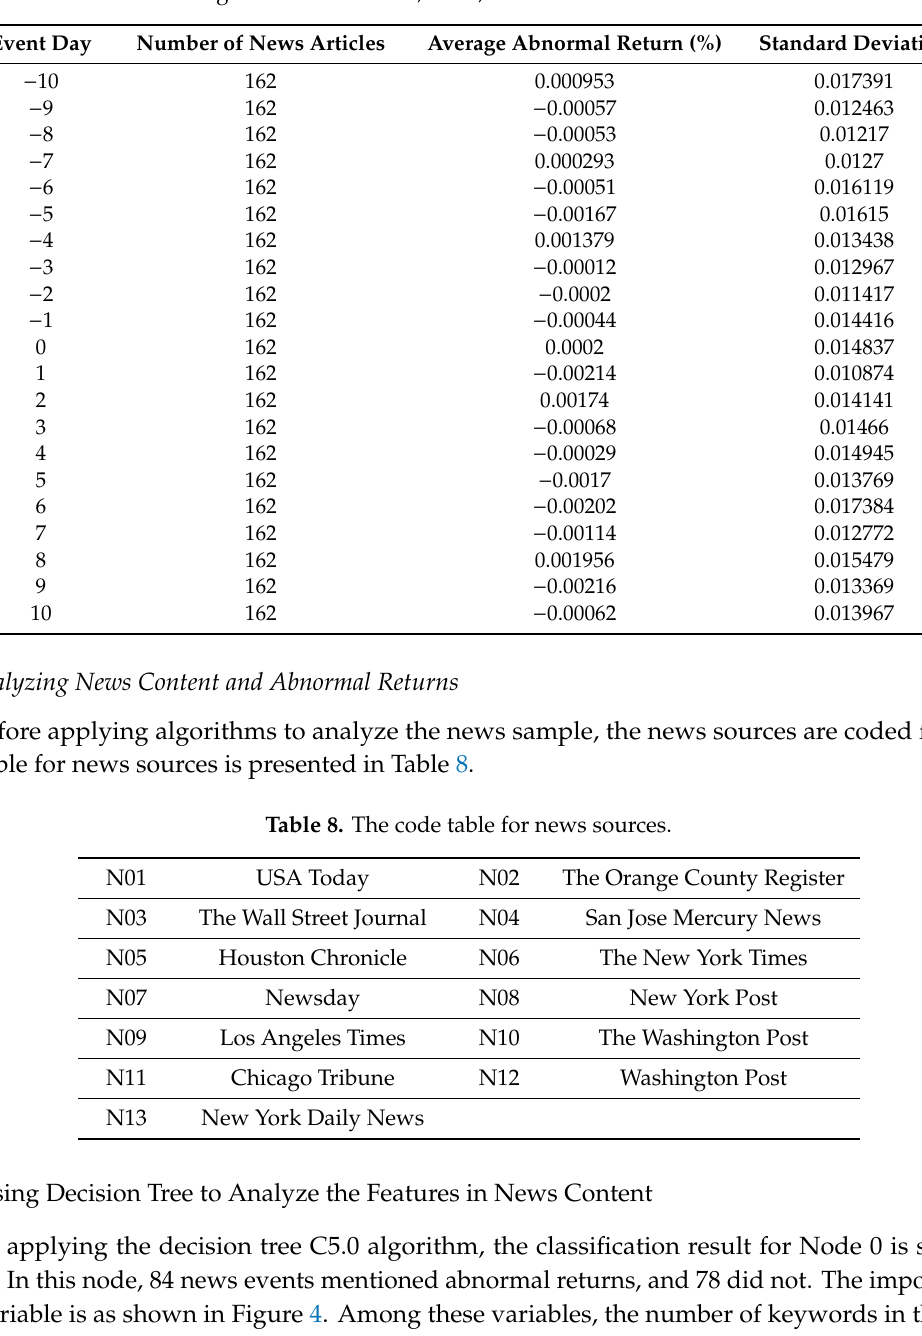
Table 7. Average abnormal returns, t-test, and standardized residual test results.